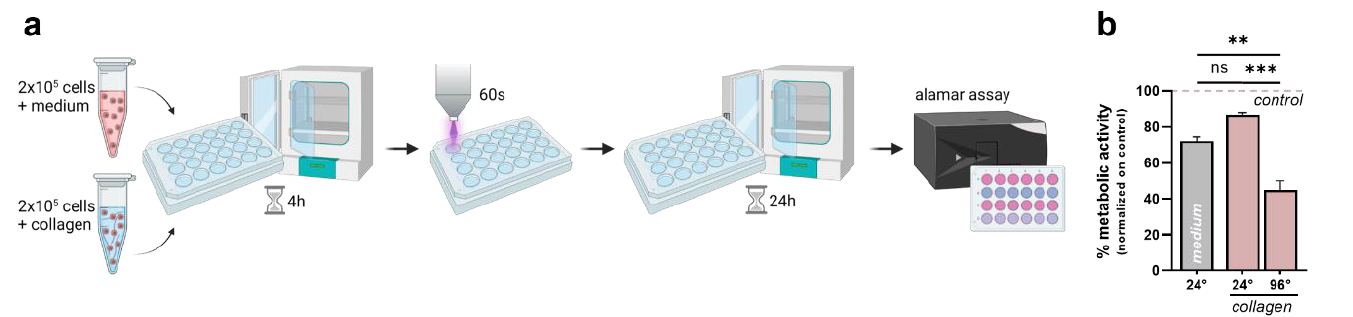
Figure 5. Differential plasma sensitivity of 3D cultured cells compared to conventional 3D culture systems. ( a ) Schematic overview of the experimental procedure; ( b ) metabolic activity of cells cultured in medium or collagen and different plate geometries 24 h after plasma treatment. The bar graphs show the mean ± standard error of the mean (SEM). The statistical analysis was performed using one-way analysis of variance (** p < 0.01; *** p < 0.001).